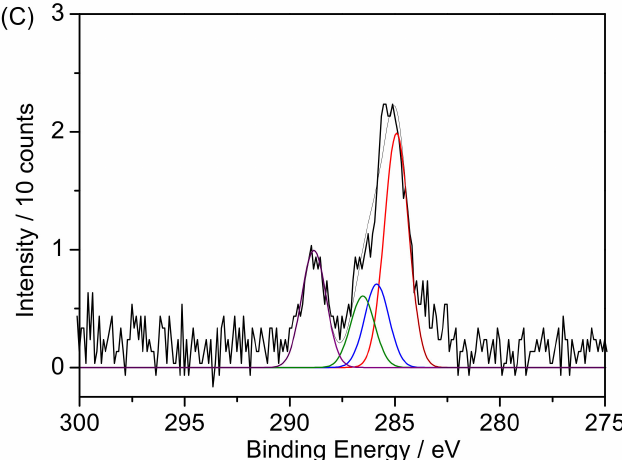
Figure 5. XPS spectra of C1s peaks for: ( A ) Fe 3 O 4 @MSN-PDEAEMA, ( B ) Fe 3 O 4 @MSN-PDEAEMA- NH 2 , and ( C ) Fe 3 O 4 @MSN-PDEAEMA-FA.